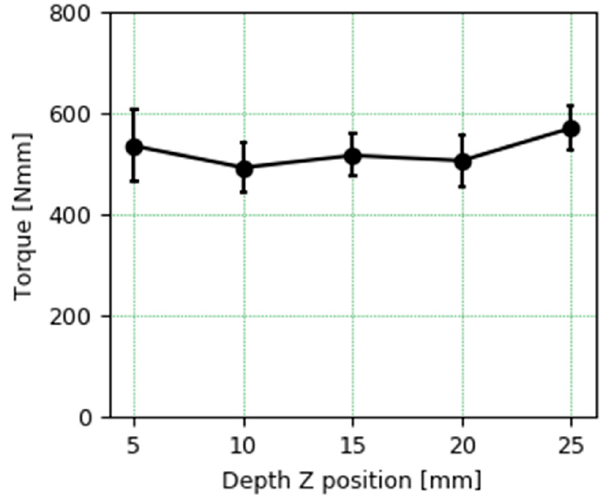
Figure 12. Torque comparison on cutting PAW-WAAM wall at different Z tool positions from 5 mm to 25 mm.